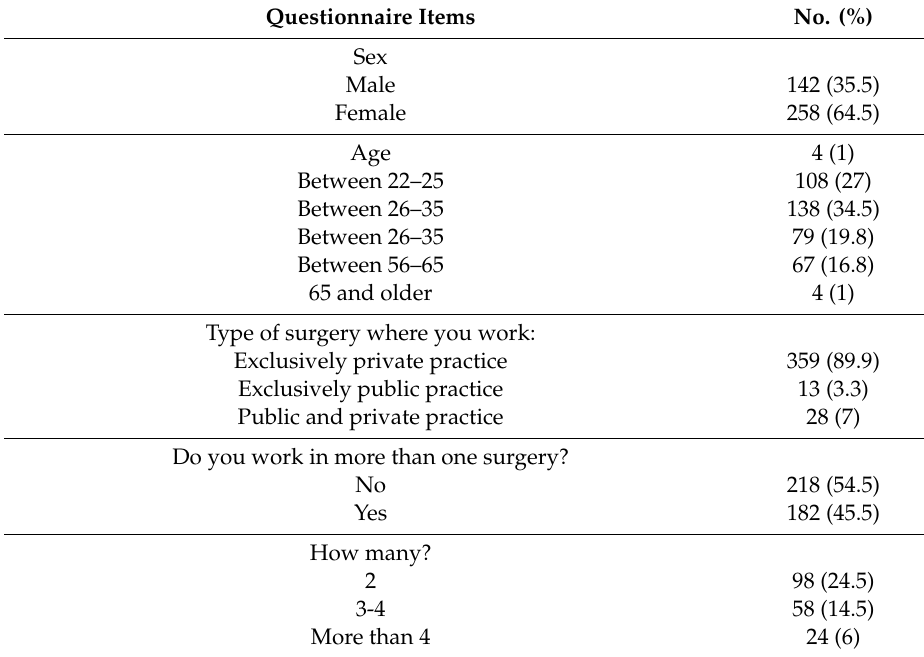
Table 1. Responses